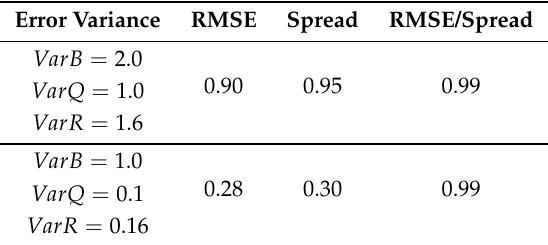
Table 1. The root mean square error (RMSE), spread and their ratio for different error